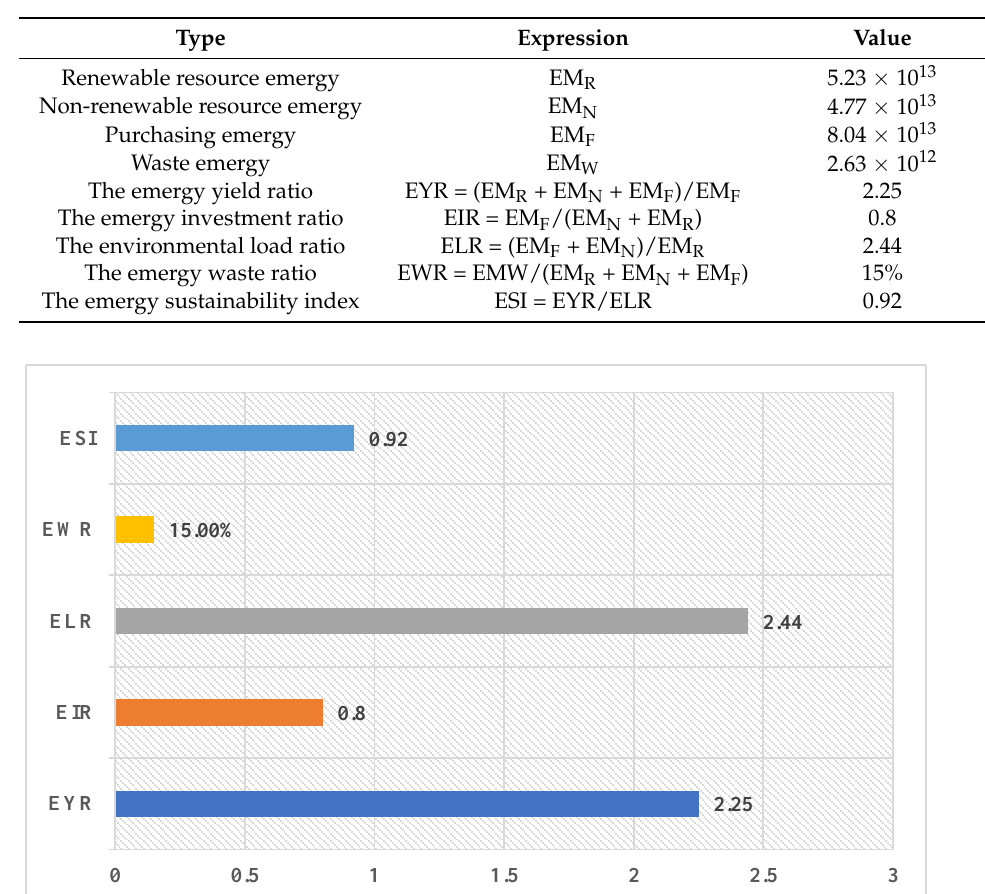
Figure 3. Sustainable development indicators of manufacturing a spur gear.